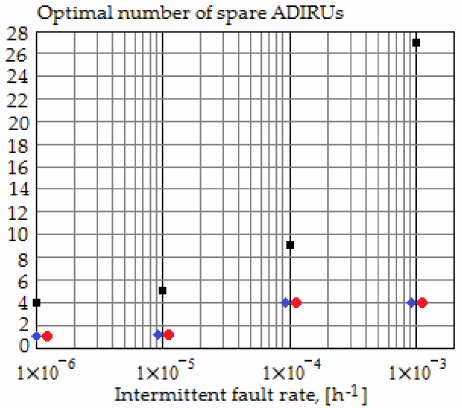
Figure 5. Expected total maintenance cost as a function of the intermittent fault rate for the first maintenance option (black squares), second maintenance option (blue rhombus), and third maintenance option (red circles).